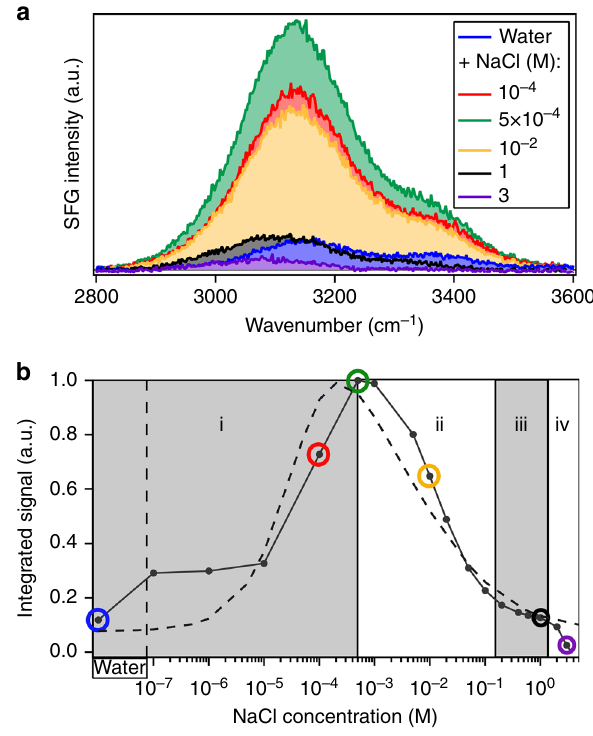
Fig. 1 SFG spectra. a O – H-stretch SFG signal for various NaCl solutions (ref. 26 ). b SFG signal intensities, integrated from 2800 to 3600 cm − 1 and normalized to the curve maximum. The spectra corresponding to the marked data points are presented in the top panel, with corresponding colors. All spectra are measured under resting conditions, directly after fl owing for 5 min. Dashed line: the predicted intensity variation by invoking modulation by charge screening and interference, at constant χ 2 and constant surface charge density, as detailed in ref.